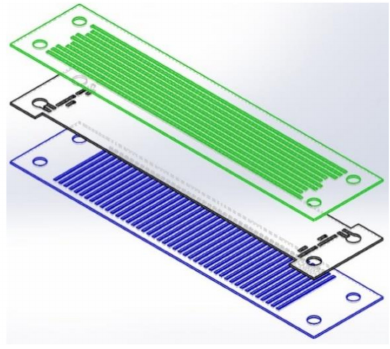
Figure 1. Exploded view of the three-layer bipolar